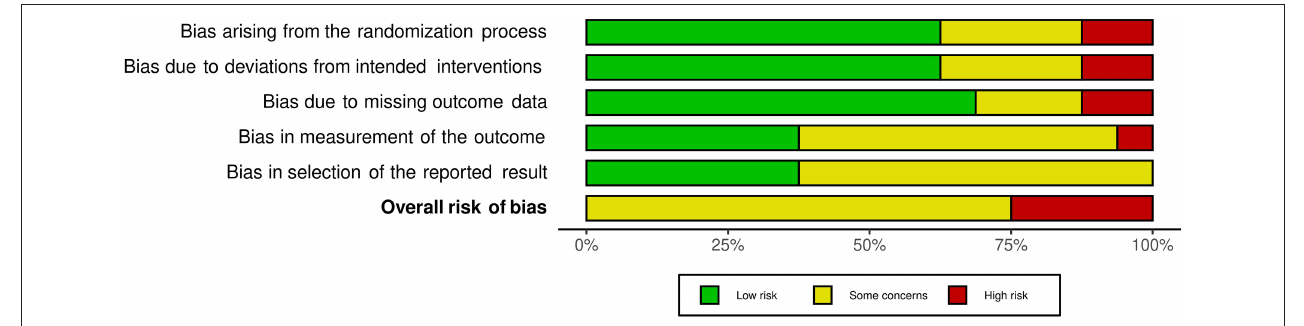
FIGURE 2 | Weighted summary plot of the overall type of bias encountered in the included studies.